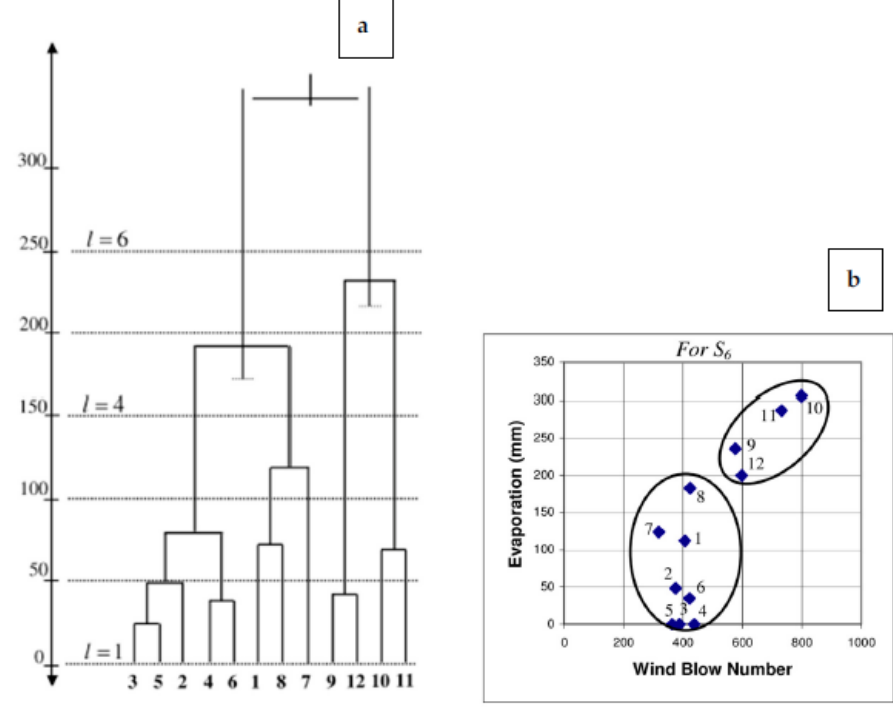
Figure 23. The dendrogram depends on the hierarchical single linkage for the second application ( a ) and detail of similarity level S6 (l6) cluster analysis ( b ) [20]. and detail of similarity level S6 (l6) cluster analysis ( b ) However, the research of Guldal et al. does not discuss the relative error or compar- ison between methods since the research only uses the non-parametric approach.